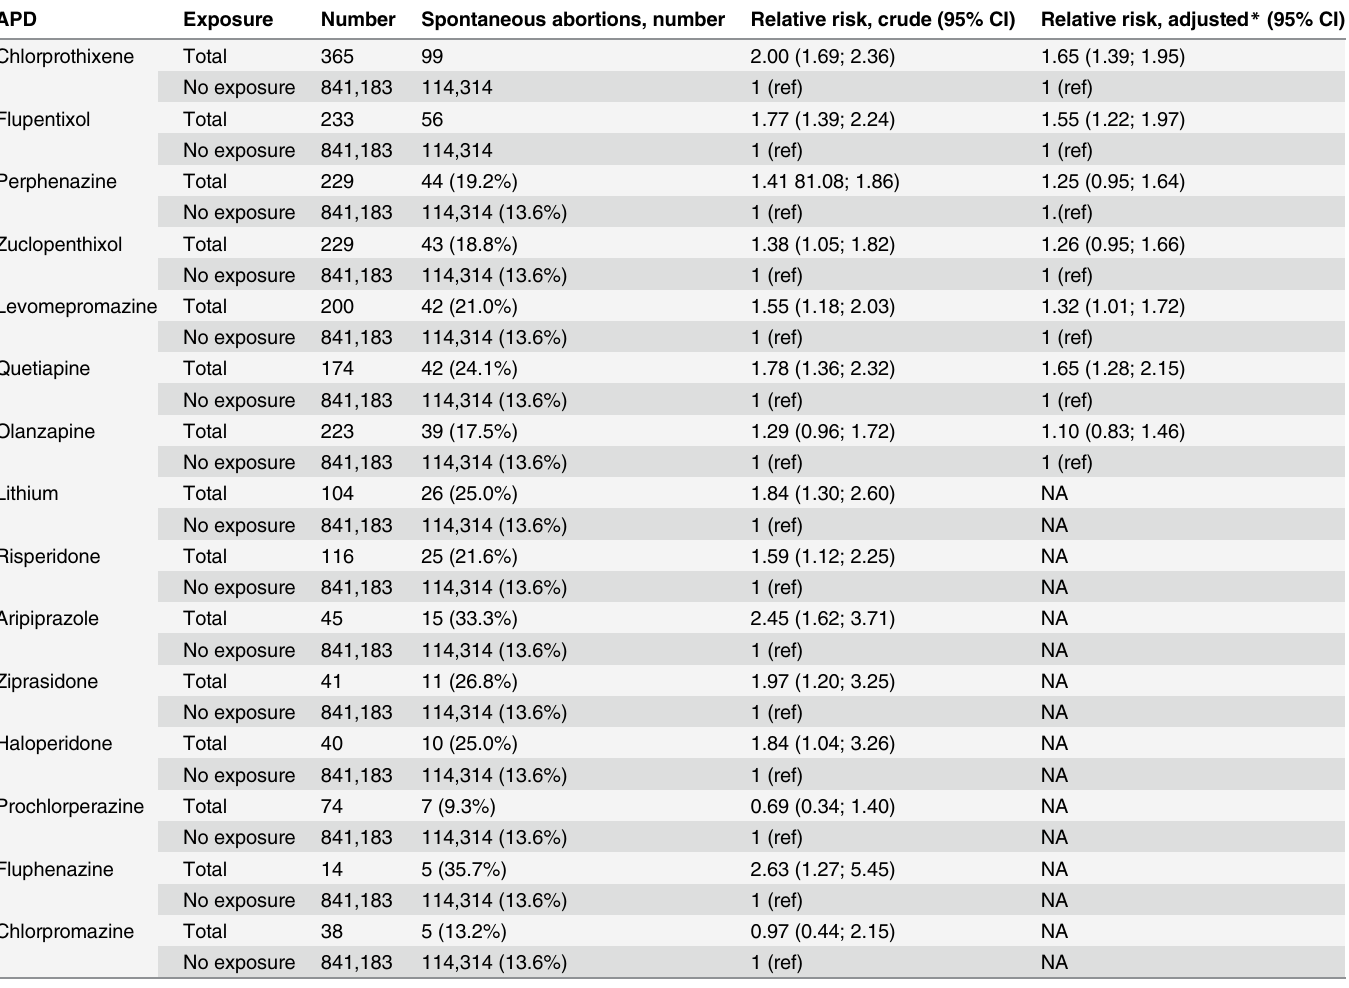
Table 5. Relative risk of SA following exposure to individual APD (numbers refer to pregnancy outcomes). APD